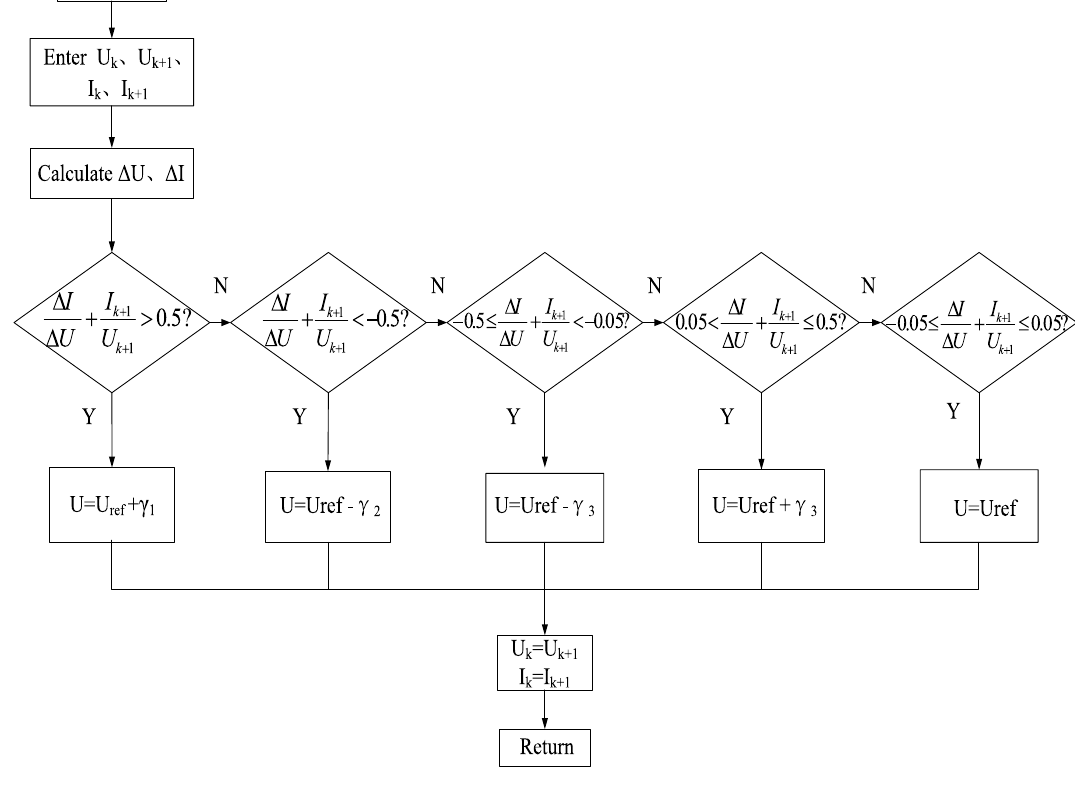
Figure 7. Flow chart of the variable-step conductance increment